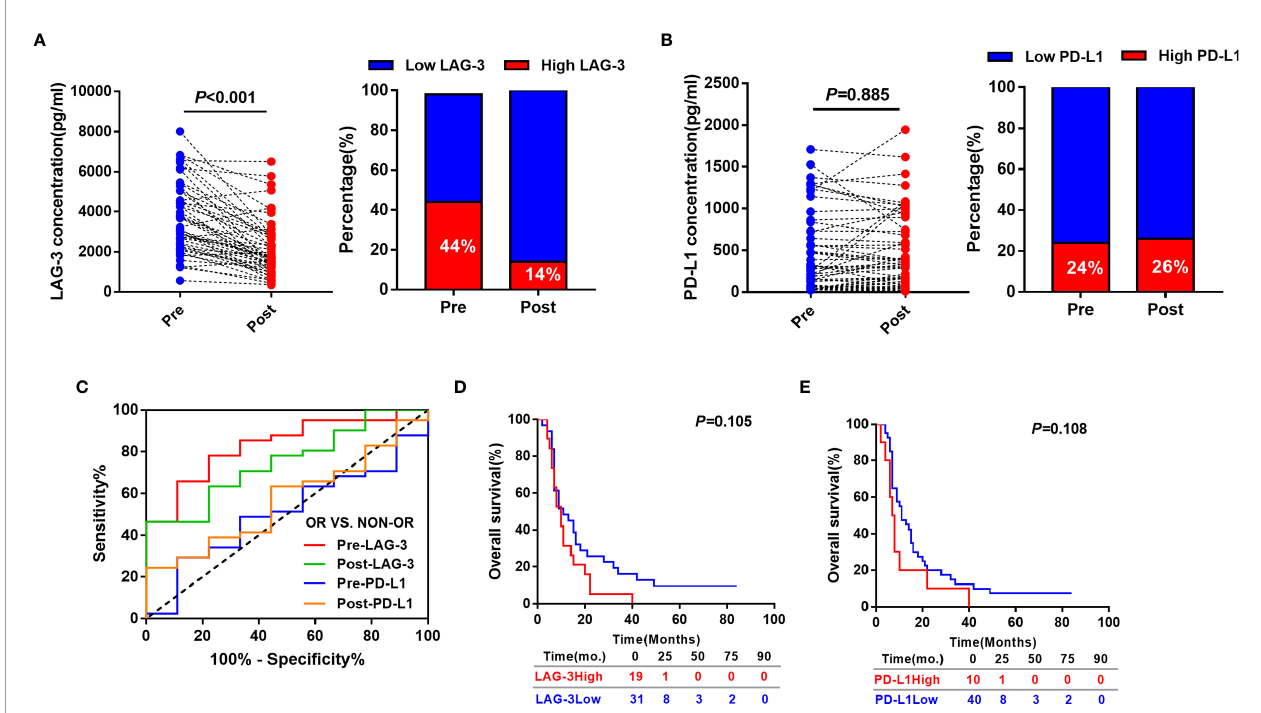
FIGURE 4 | Predictive and prognostic values of post-TACE serum LAG-3 and PD-L1 levels in HCC patients underwent TACE. (A) Distribution of serum LAG-3 level (left) and proportion of high LAG-3 (right) in HCC patients before and after TACE. (B) Distribution of serum PD-L1 level (left) and proportion of high PD-L1 (right) in HCC patients before and after TACE. (C) ROC curve analysis of pre-TACE and post-TACE serum LAG-3 and PD-L1 level for the discrimination between OR and non-OR patients. (D) Kaplan-Meier curve of OS according to post-TACE LAG-3 level in HCC patients received TACE. (E) Kaplan-Meier curve of OS according to post-TACE PD-L1 level in HCC patients received